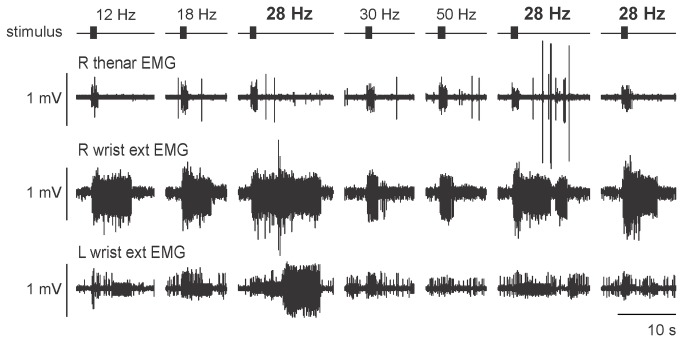
Self-sustained activity in response to 1-s trains of stimuli at different frequencies.All data were recorded within a 10-min period. Although 28 Hz produced the most consistent and longest responses, the amplitude and duration of the response, even at the same frequency varied from trial to trial. Responses were typically shorter at frequencies above 28 Hz. Data are shown in the order in which they were obtained, but some trains have been omitted.